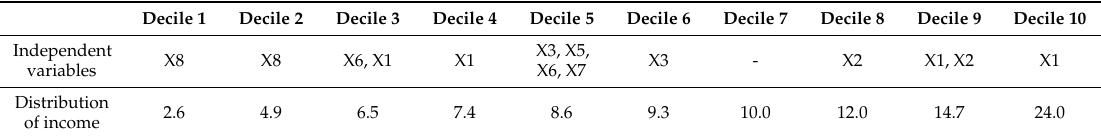
Table 4. Predicted distribution of Polish households’ disposable income by decile groups in May 2020 and its impact factors.